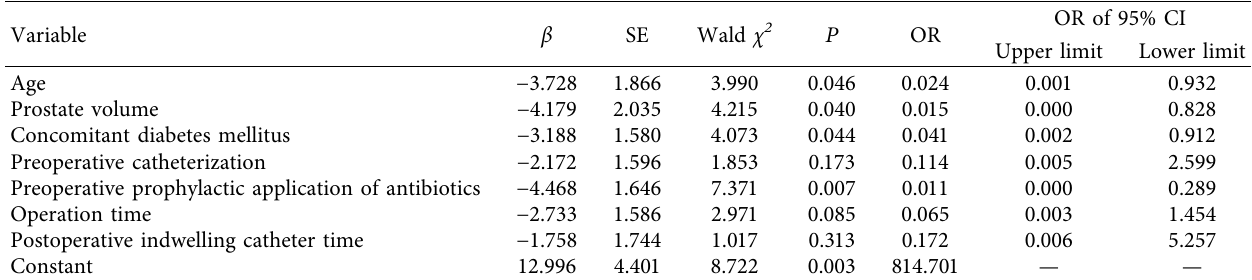
Table 3: Analysis of multiple factors affecting postoperative urinary-derived pathogenic bacteria infection in patients with BPH. Variable